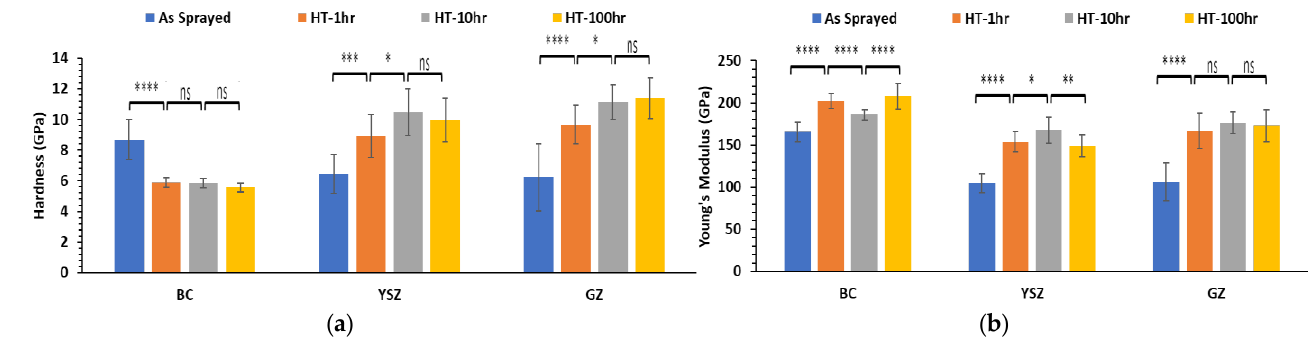
Figure 14. Nanoindentation data of the double layer TBC before and after thermal treatment ( a ) hardness (H), ( b ) elastic modulus (E). Asterisks indicate a statistical difference (* p < 0.05, ** p < 0.01, *** p < 0.001, **** p < 0.0001, as obtained using Tukey test, which computes a confidence interval for the difference between two means).